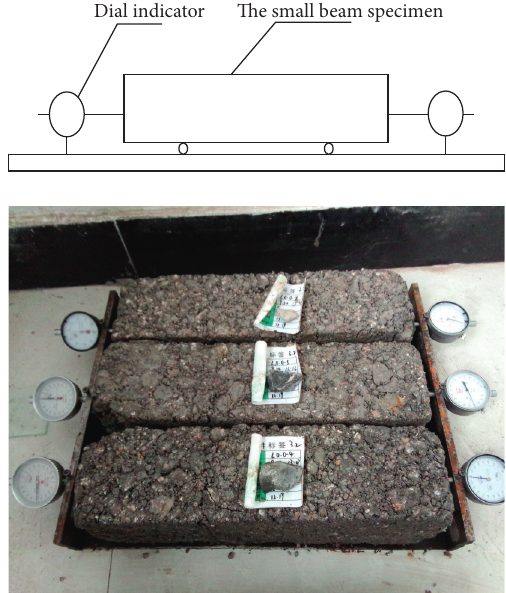
Figure 8: Sketch map of drying shrinkage test and test apparatus and test apparatus.